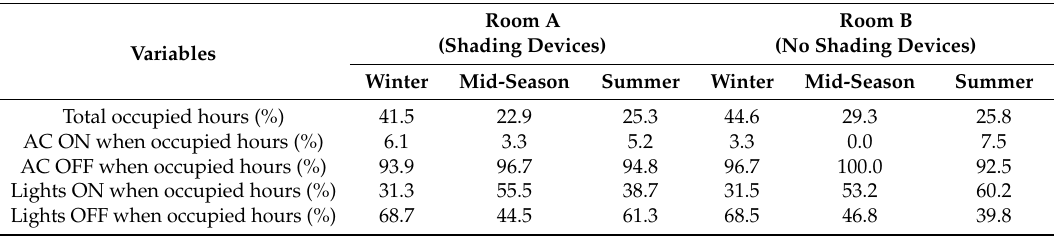
Table 5. Percentage of occupied hours and activation of air conditioning and lighting systems. Data shown for each period and classroom